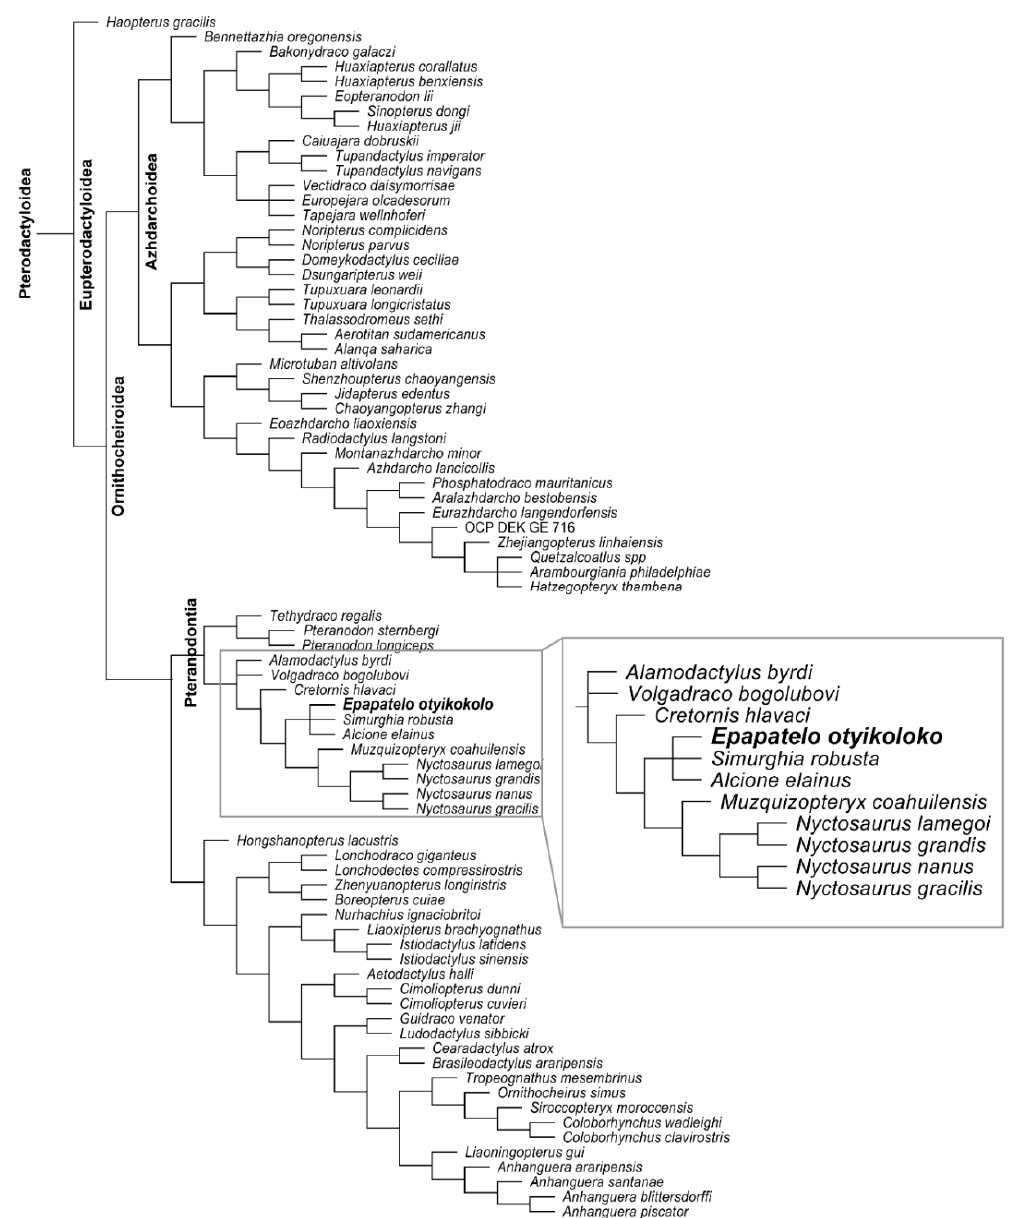
Figure 9. Adams consensus cladogram. Based on the four resultant equally parsimonious trees from the phylogenetic analysis of Longrich et al. 2018 [17] with the addition of Epapatelo otyikokolo , gen. et sp. nov. (articulated humerus and ulna, with articulated radius and ulna). These trees differ only in their placement of Volgadraco bogolubovi Averianov et al. 2008 [42], which is shown at its most basal position recovered.